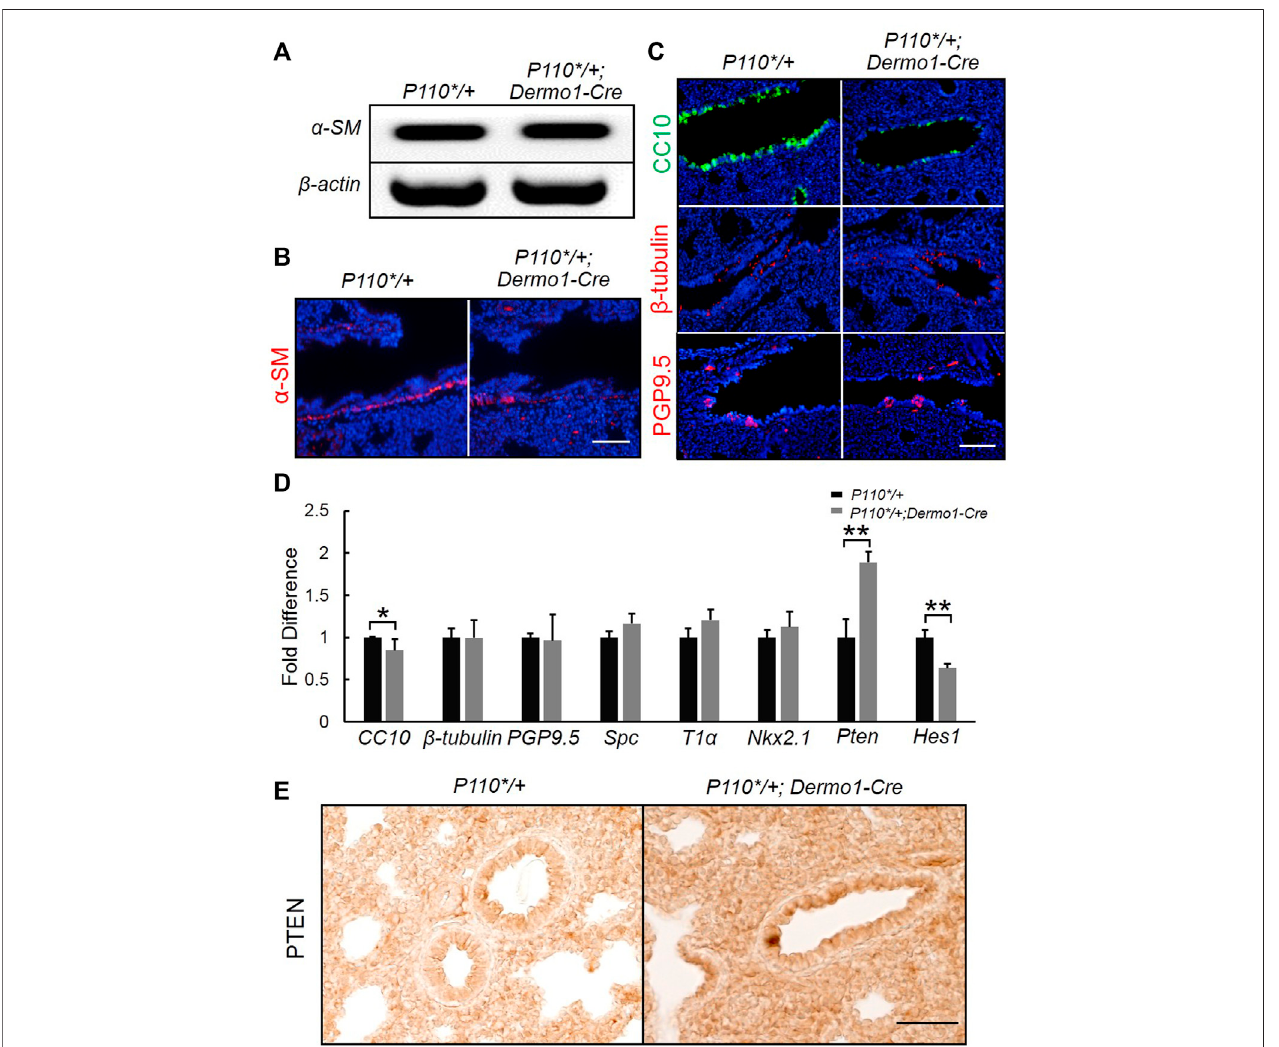
FIGURE 4 | Activation of p110 α resulted in a decrease in the number of club cells. Real-time PCR analysis (A) and IF staining analysis (B) of α -SM cells in E17.5 control and P110*/+ ; Dermo1-cre lungs. (C) . IF staining analysis of CC10, ß -tubulin, and PGP9.5 in E17.5 control and P110*/+ ; Dermo1-cre lungs. (D) . Real-time PCR analysis of CC10, β -tubulin, PGP9.5, Spc, T1 α , Nkx2.1, Pten, and Hes1 in E17.5 control and P110*/+ ; Dermo1-cre lungs. (E) . Immunolocalization analysis of PTEN in E17.5 control and P110*/+; Dermo1-cre lungs. The bars represent the mean ± SD. N > 3. *p < 0.05, ** p < 0.01 Scale bar: 50 μ m.